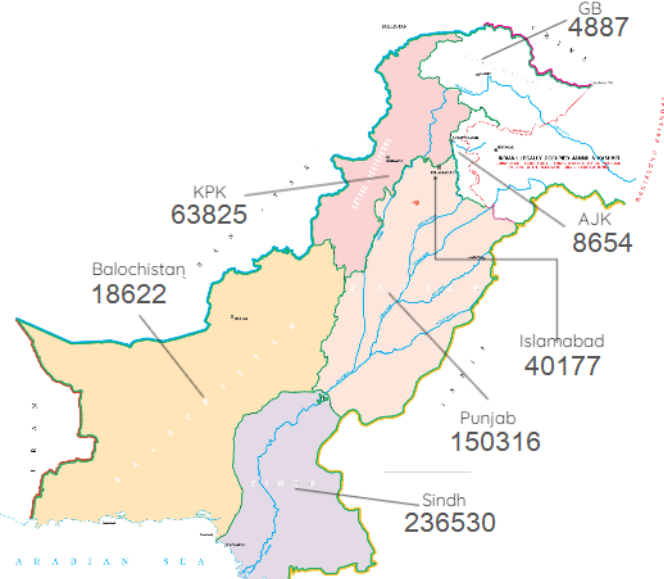
Figure 3. Map view of COVID-19 situation in Pakistan.